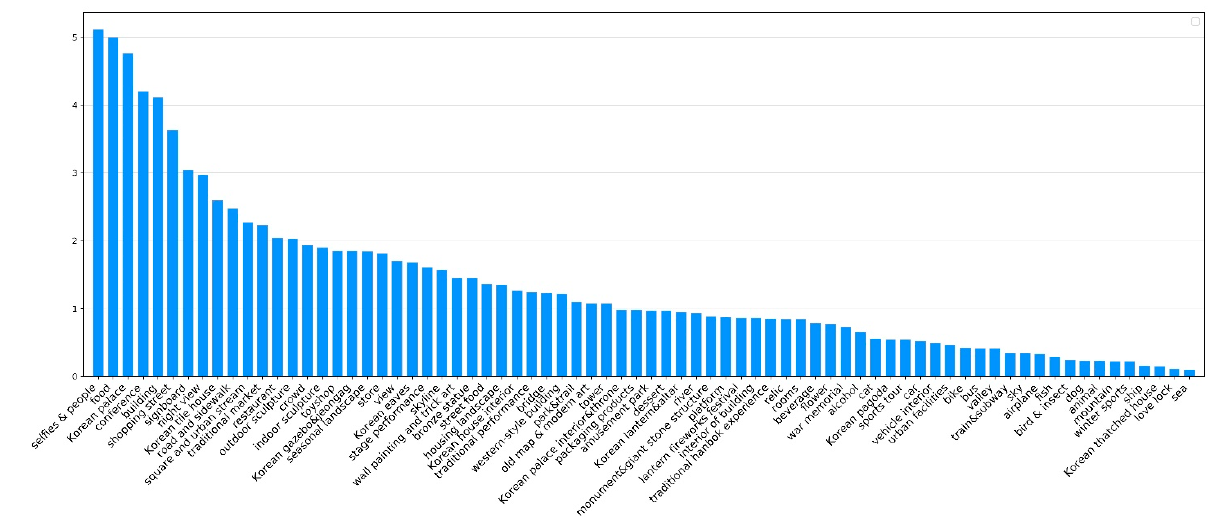
Figure 10. Percentage of photos by 74 scenes in descending order.